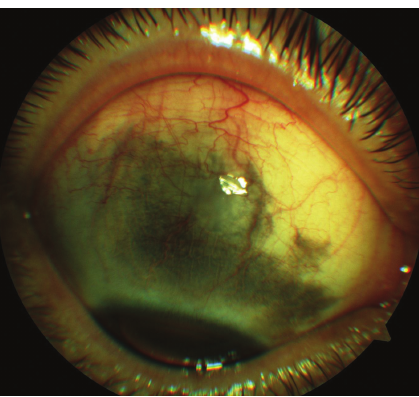
Figure 1: Slit-lamp photograph shows bluish-grey pigmentation of the right conjunctiva, episclera, and sclera.